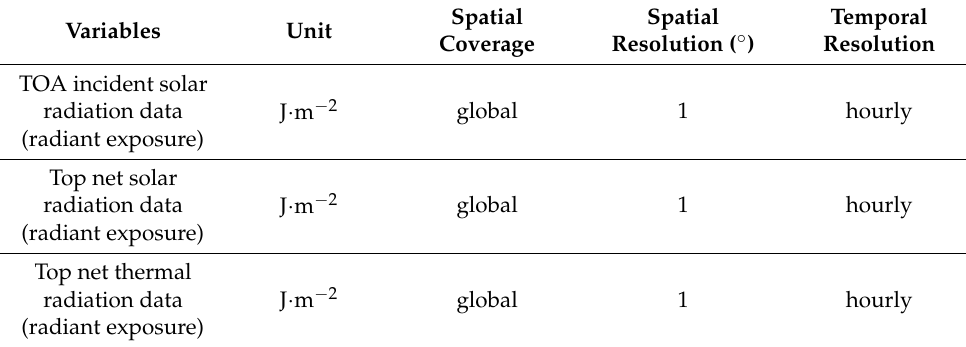
Table 1. The variables of ERA5 related to TOA radiative